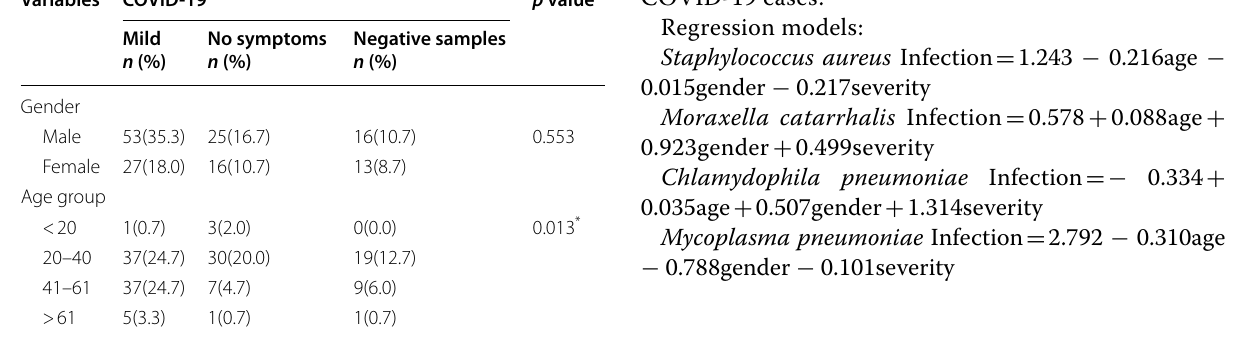
Table 3 Distribution of bacteria among mild, asymptomatic, and negative COVID‑19 patients Nasal carriage of bacteria